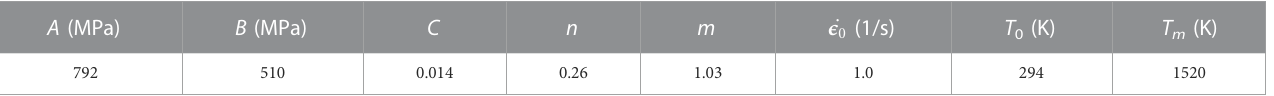
TABLE 2 Johnson-Cook parameters for AISI 4340 steel (Afazov et al., 2010). Here, _ ϵ 0 is the equivalent plastic strain rate and σ Y the material yield stress at zero strain. B and n are strain hardening parameters, C a strain rate parameter, m a temperature coef fi cient, and T m the melting